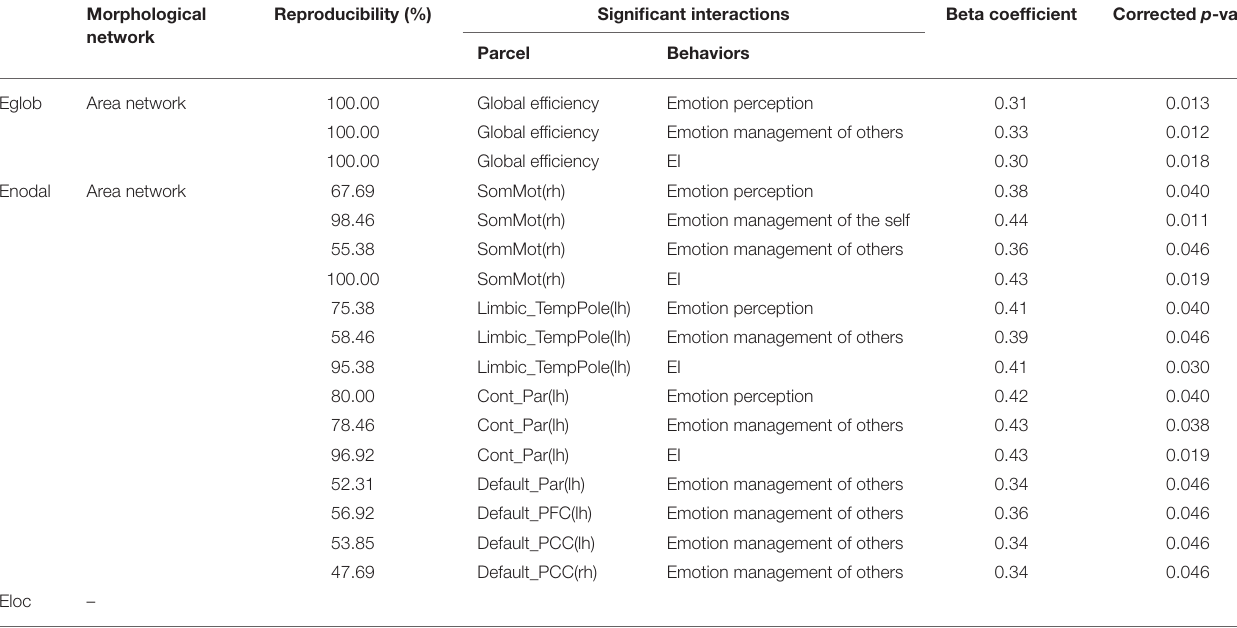
TABLE 5 | The significant age × network efficiency interactions in emotional